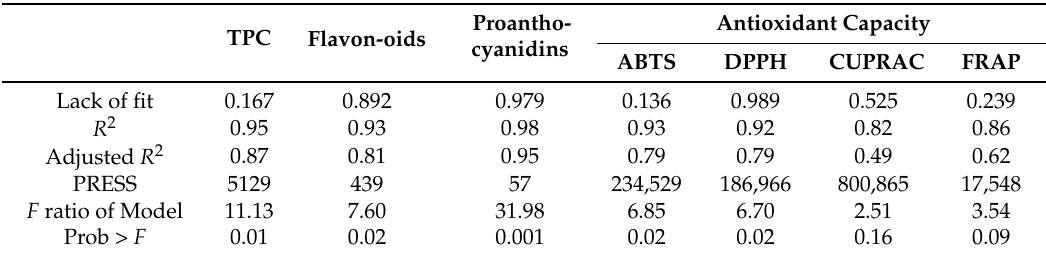
Table 2. Analysis of variance for the determination of model fitting.